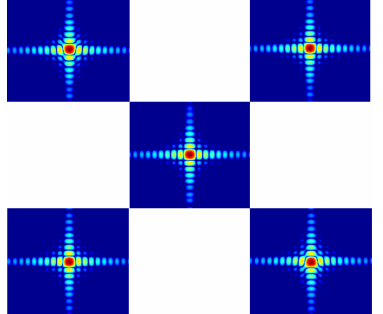
Figure 17. Imaging results of Case 2 with the BTD error